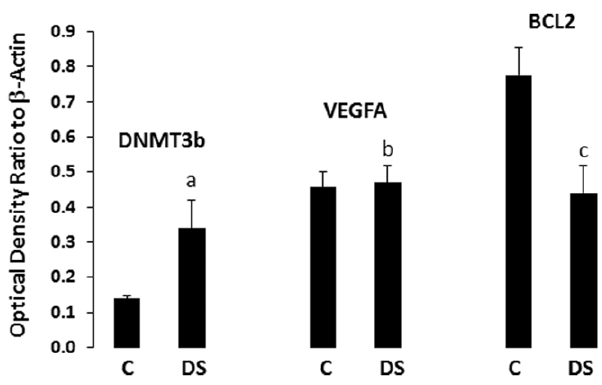
Figure 2. Protein levels of DNMT3b, BCL2, and VEGFA in PFC of depressed suicide (n=18) and normal control (n=17) subjects. Protein samples from tissue lysates were subjected to 10% polyacryl- amide gel electrophoresis and transferred to enhanced chemilumines- cence–nitrocellulose membranes, which were then incubated with primary antibody specific for DNMT3b, BCL2, VEGFA or b -actin and corresponding secondary antibody. The suicide group was compared with the control group. DMNT3b was strongly up-regulated (2.4-fold) in the depressed suicide group ( a p=1 6 10 2 11 ), VEGFA showed no significant change (1.03-fold, b p=0.4) and BCL2 was strongly down- regulated (0.57 of control, c p=2.4 6 10 2 14 ). C=Controls; DS=Depressed